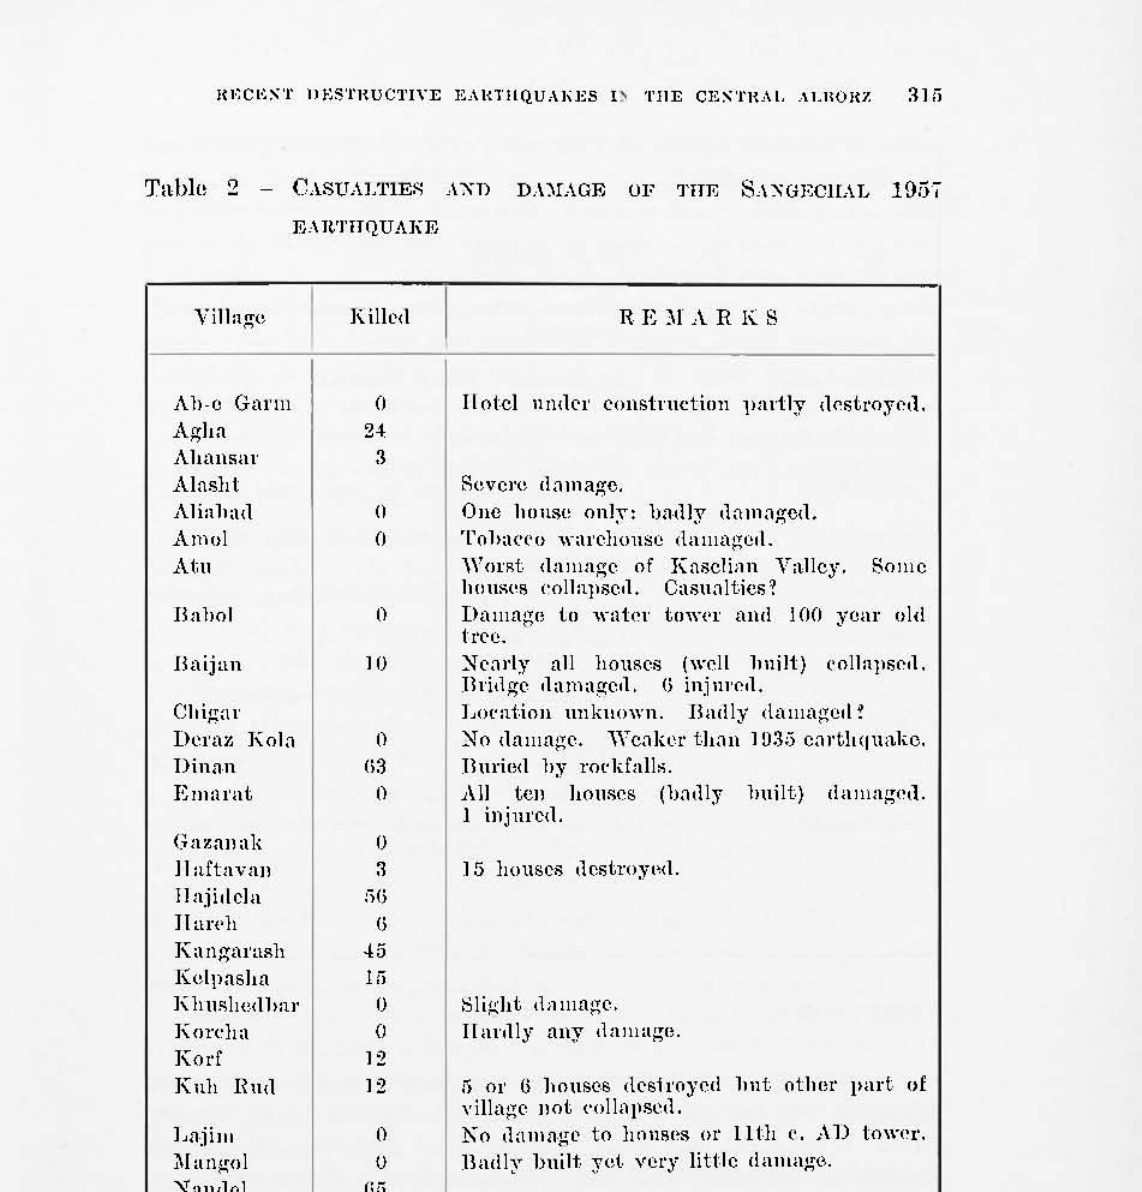
Table 2 CASUAl:l'1E.~